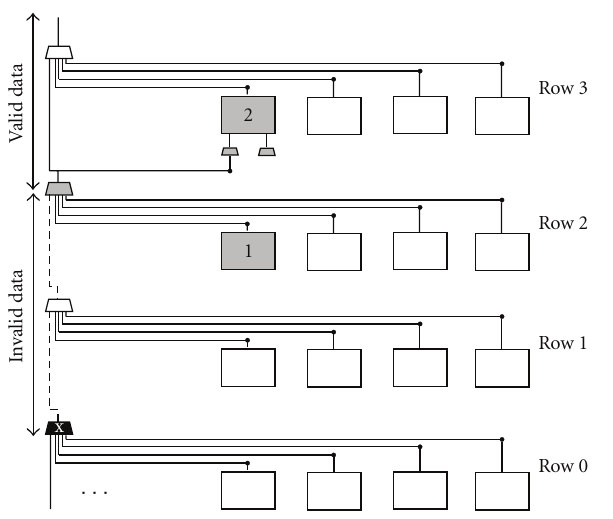
Figure 10: Defective output multiplexer/reading case solution— since instruction 1 has written in context line after defective multi- plexer (after row 0) and before instruction 2 reads from this context line (before row 3), then, instruction 2 can read the correct data.